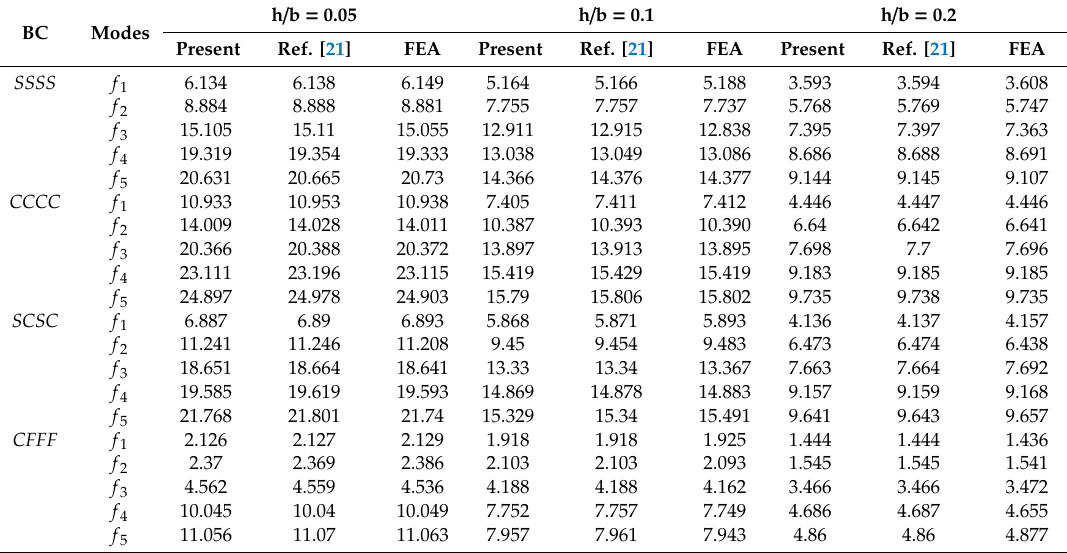
Table 4. Natural frequency parameters for rectangular laminated plates with SSSS , CCCC , SCSC and CFFF